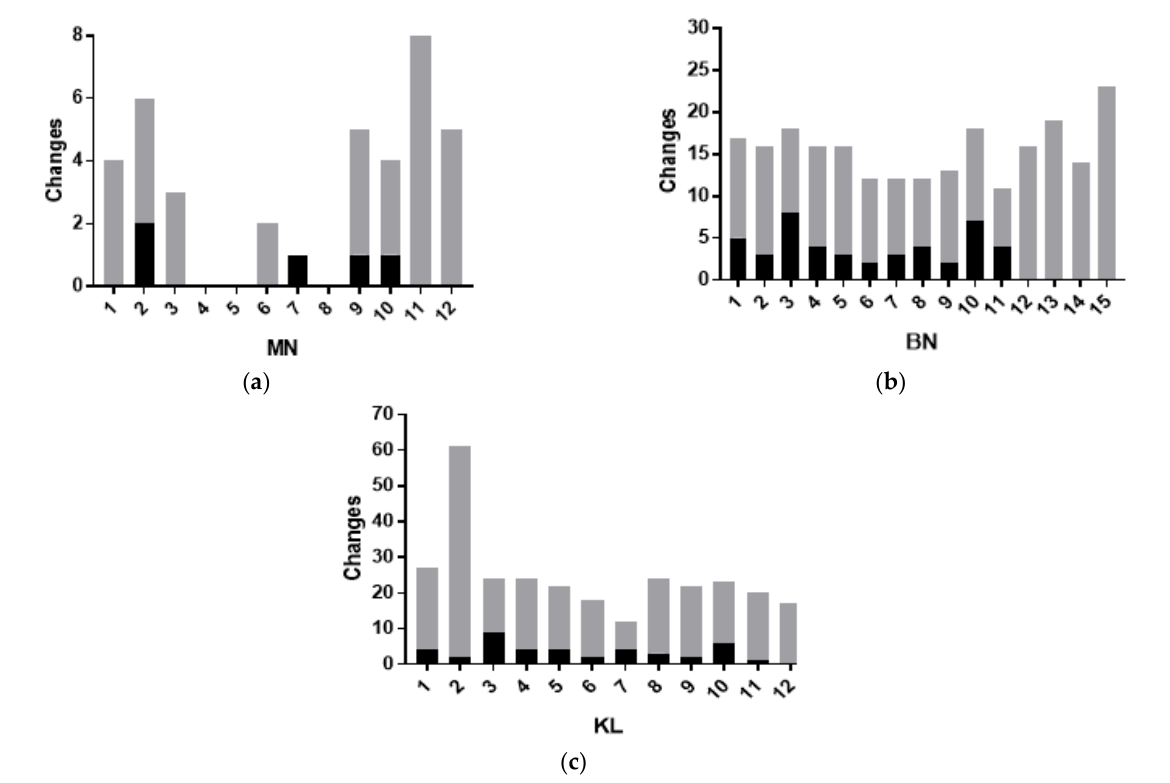
Figure 4. Influence of alcohol consumption on the distribution in the control (black) and exposed groups (gray). p < 0.05 according to the sample paired t -test. ( a ) Micronucleus (MN), ( b ) binucleated (BN), and ( c ) karyolitic (KL).